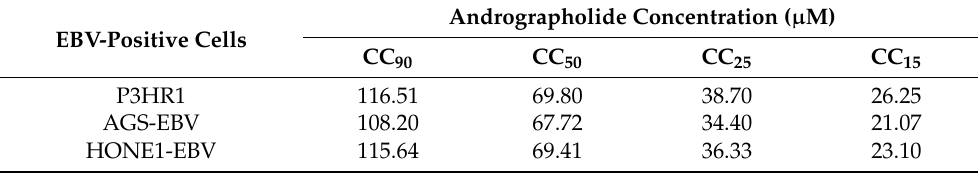
Table 1. The CC 90 , CC 50 , CC 25 and CC 15 values for andrographolide were evaluated in P3HR1, AGS-EBV and HONE1-EBV